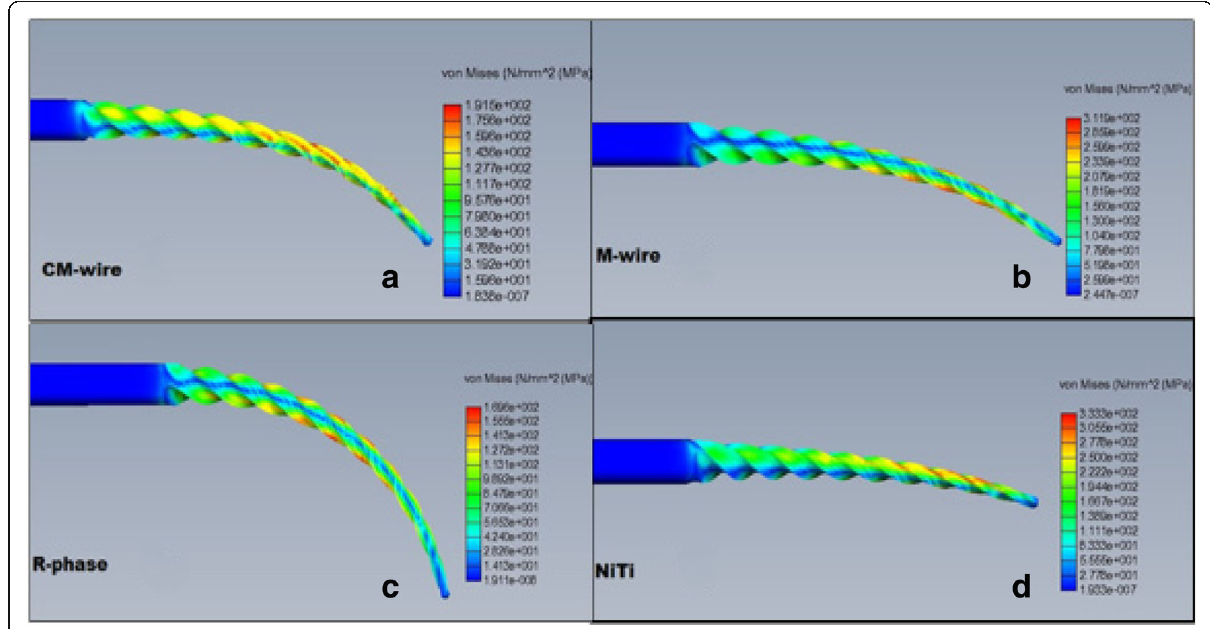
Fig. 2 a – d Stress distribution during bending of CM-wire, M-wire, R-phase, and NiTi FE models,